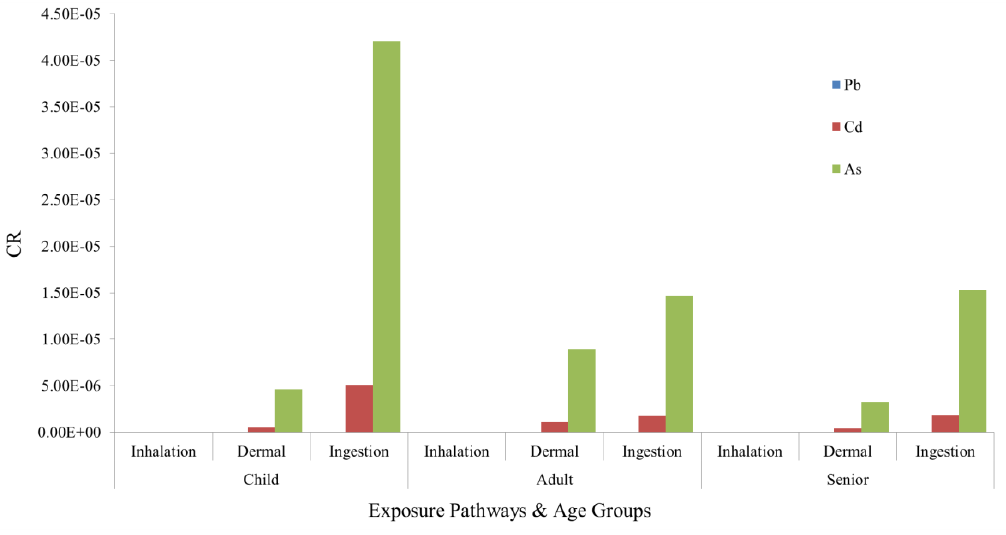
Figure 5. CRs of the different elements for different age groups under different exposure pathways.